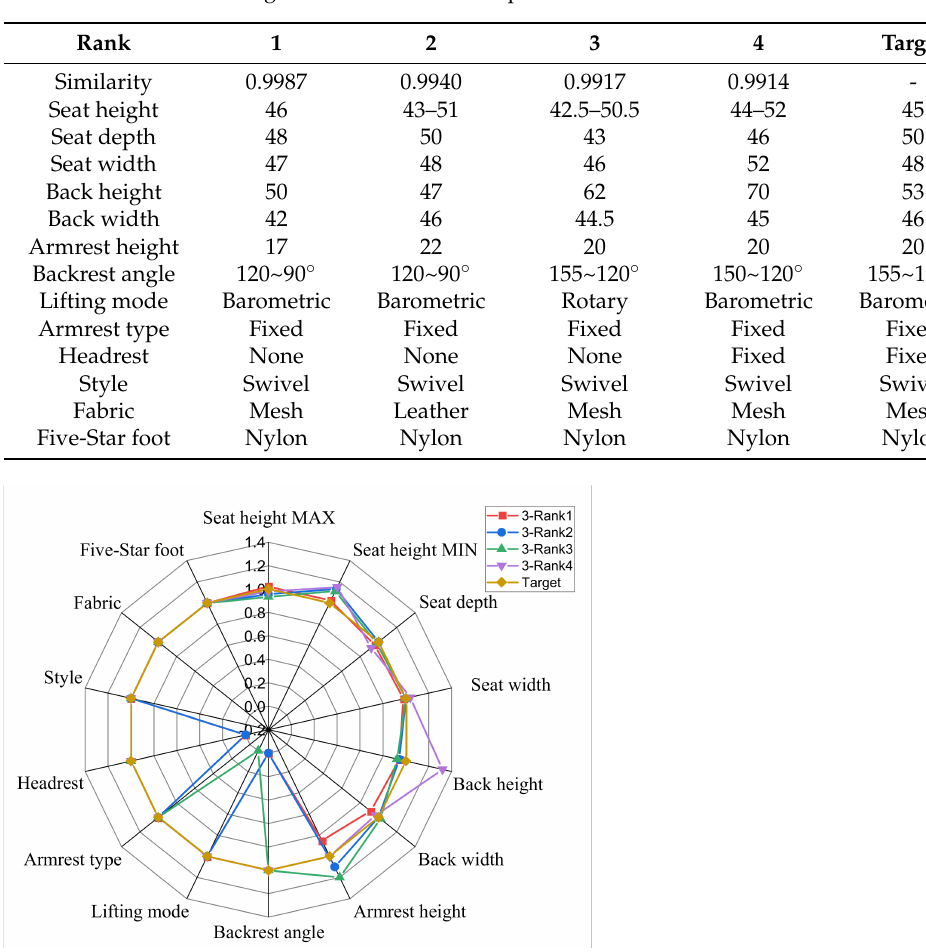
Table 7. The results of weighted K-NN office chair pattern retrieval.